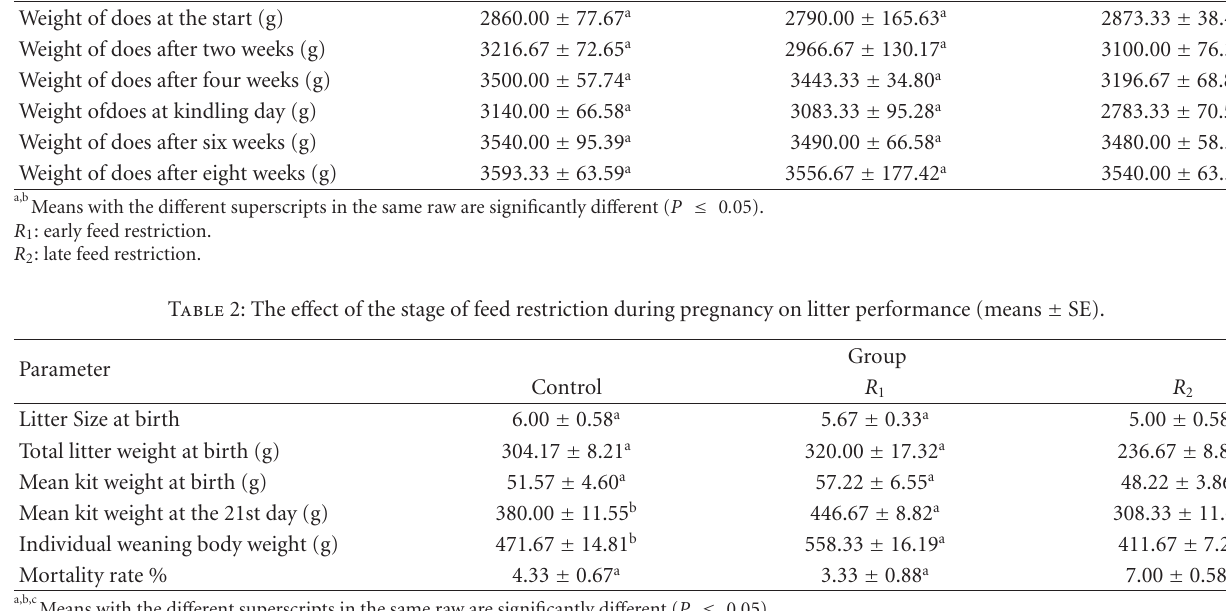
Table 1: The e ff ect of the stage of feed restriction during pregnancy on maternal body weights (means ± SE). Parameter Weight of does at the start (g) Weight of does after two weeks (g) Weight of does after four weeks (g)